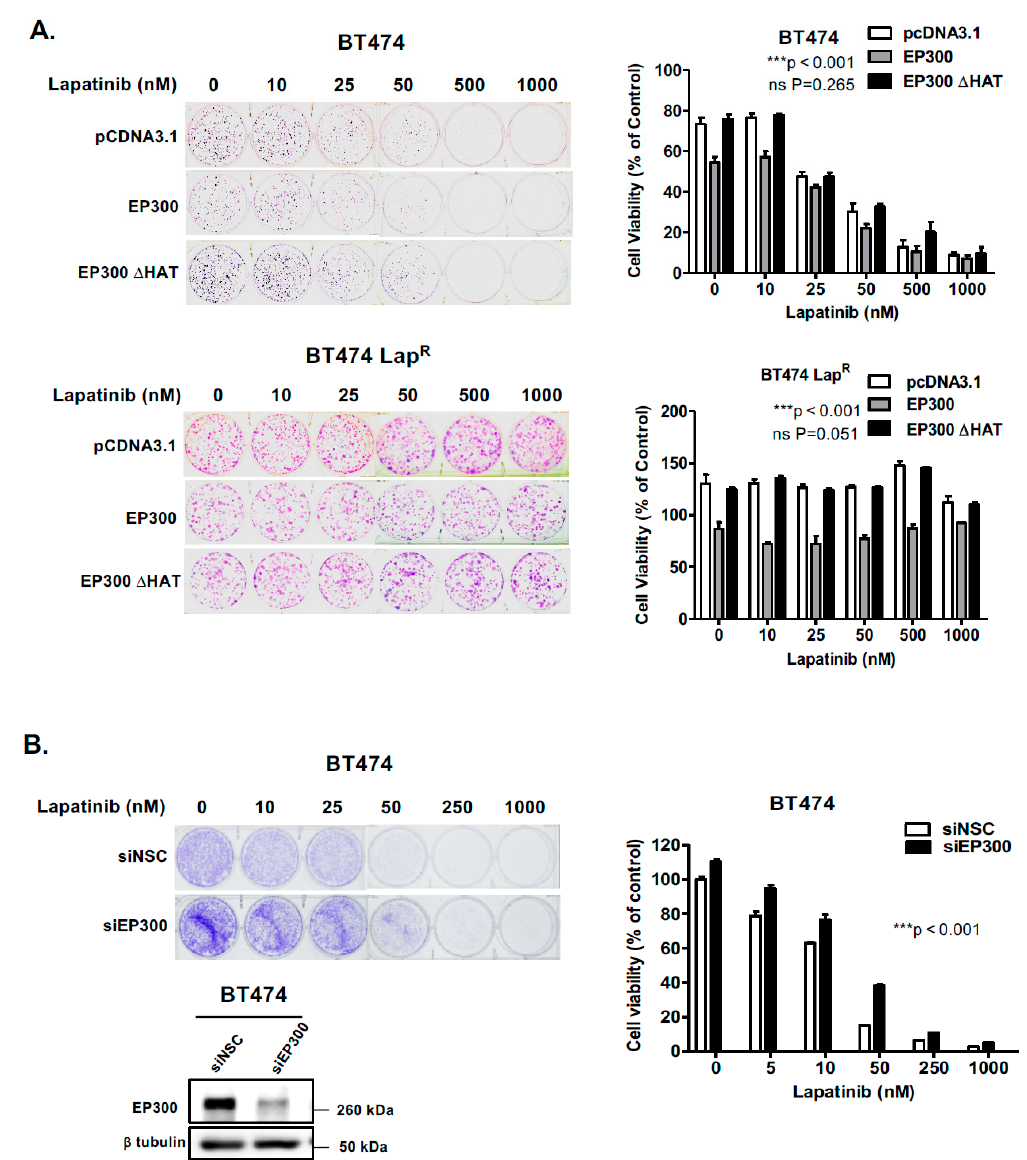
Figure 5. EP300 expression correlates with increased long-term lapatinib cytotoxicity in sensitive but not BT474 Lap R cells. ( A ) BT474 and lapatinib resistant BT474 Lap R cells were seeded 2000 and 1000 cells per well, respectively, in 6-well plates and transfected with the empty vector pcDNA3.1, wild-type EP300 or EP300 ∆ HAT mutant expressing vector. ( B ) BT474 cells were seeded 2000 cells per well and transfected with non-targeting control (siNSC) or EP300-targeting siRNA pools. The transfected cells were then allowed to grow overnight and then treated with the lapatinib concentrations indicated (0,10, 25, 50, 500 and 1000 nM). Western blot analysis demonstrated EP300 depletion (lower panel). Twenty-four hours following treatment the medium was changed and colony formation was allowed for 28 and 14 days in sensitive and resistant BT474 cells, respectively. Cells were then fixed with 4% para formaldehyde and stained with crystal violet. The stain was solubilized with 33% acetic acid and absorbance obtained at 592 nm. Values obtained were converted to percentage of viability with untreated cells carrying the empty vector set to 100% viability. Data were finally normalized to the respective untreated empty-vector transfected cells. Bars represent the mean ± SEM of three independent transfection experiments ( n = 3, R = 3) and statistical analysis was performed using ANOVA analysis (* p < 0.05, ** p < 0.01, *** p < 0.001) comparing the EP300, EP300 ∆ HAT or siEP300-transfected cells versus